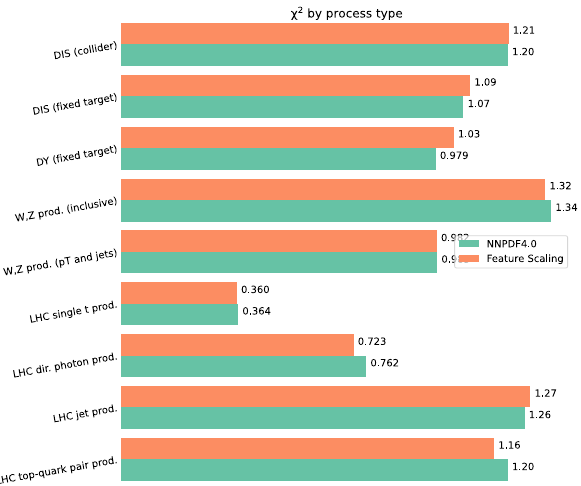
Fig. 5 A comparison of the χ 2 per process type between NNPDF4.0 (green) and feature scaling (orange), the total χ 2 of feature scaling is 1.17 while that of NNPDF is